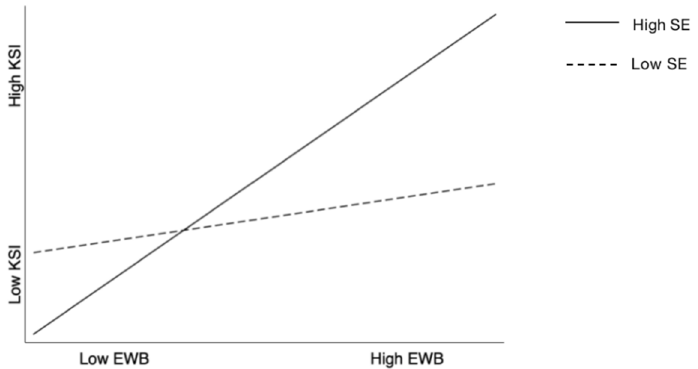
Figure 2. The moderating effect of self-efficacy on the relationship between employee well-being and knowledge sharing intention. EWB = employee well-being SE = self-efficacy KSI = knowledge sharing intention.